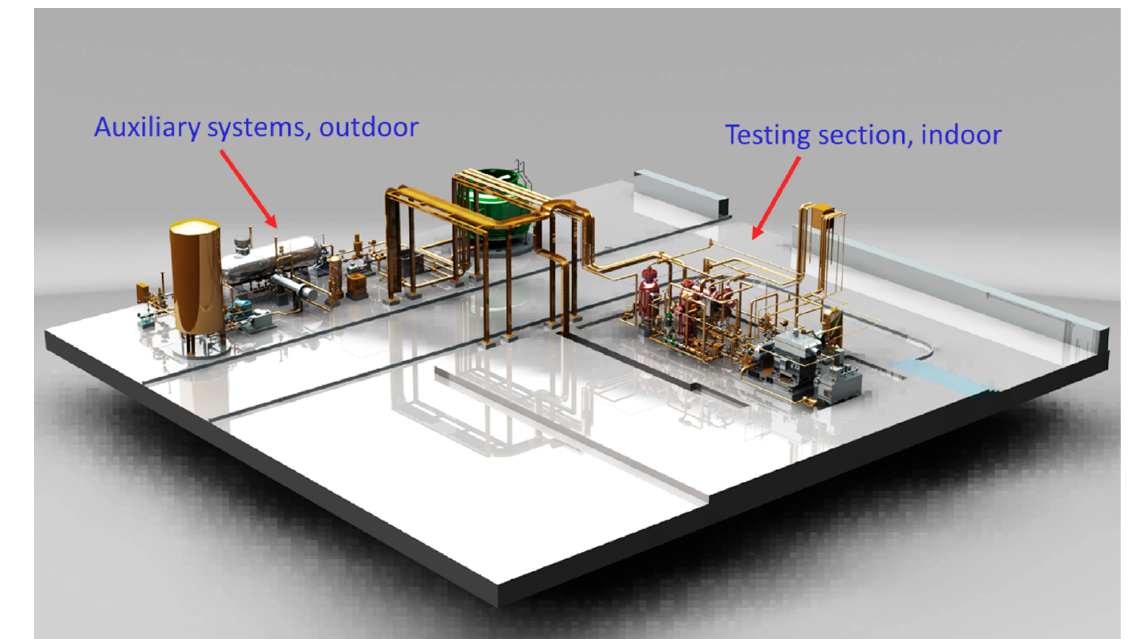
Figure 7. 3-D graphic model of the general experimental platform.